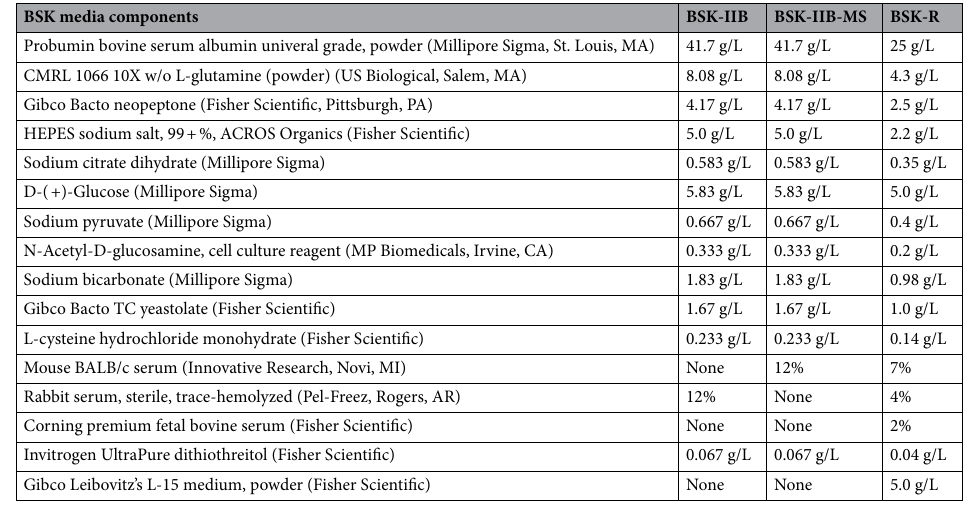
Table 1. BSK media